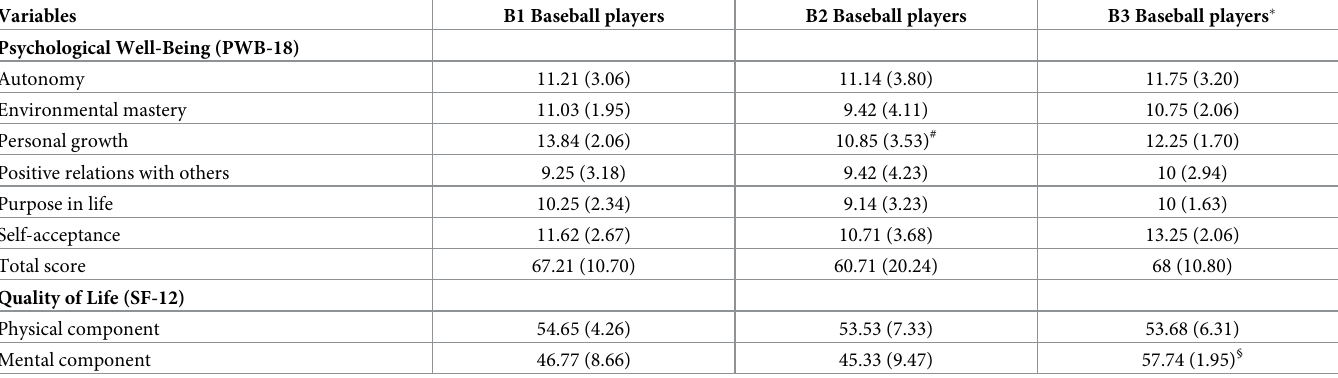
Table 5. Mean scores of psychological well-being scale and quality of life questionnaires in visually impaired baseball players stratified according to the visual dis- ability level. Variables